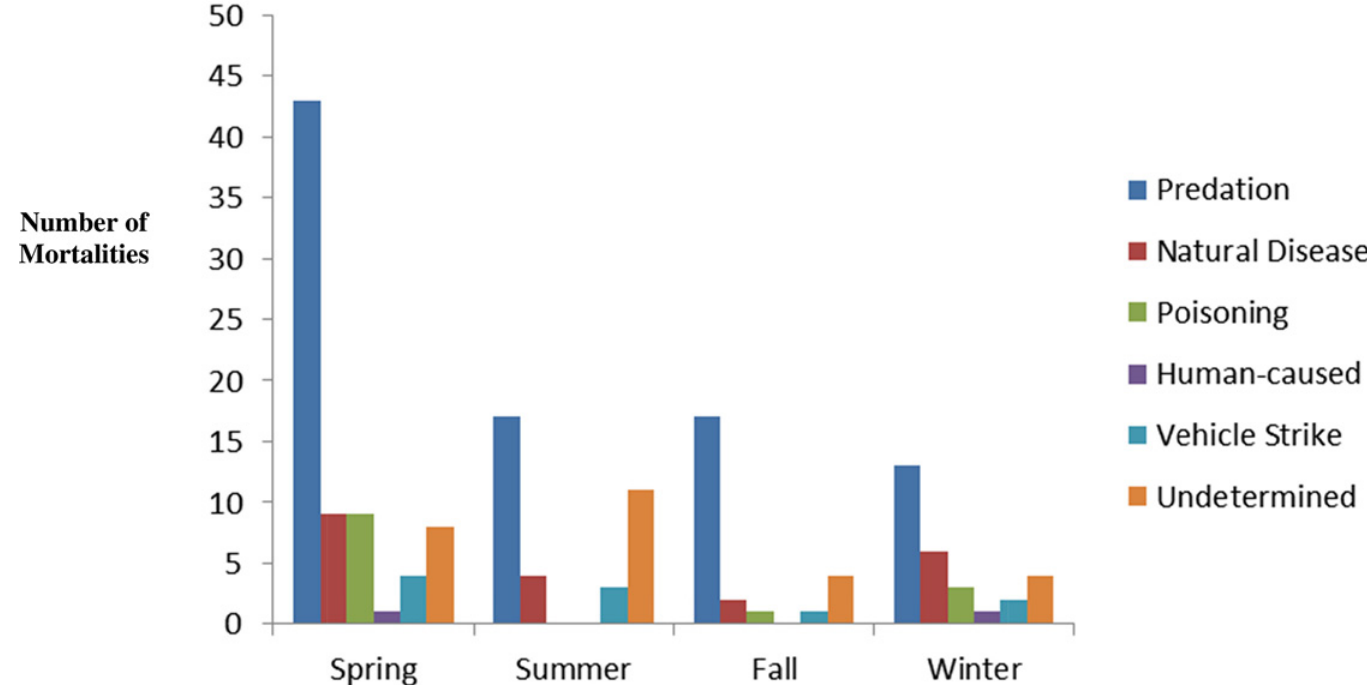
Fig 1. Contributions of each necropsy-determined cause of mortality confirmed by full necropsy and/ or forensic analysis over the seasons for California fisher ( Pekania pennanti ) populations in northern California and the southern Sierra Nevada. Data were combined from 2007 to 2014 (n =